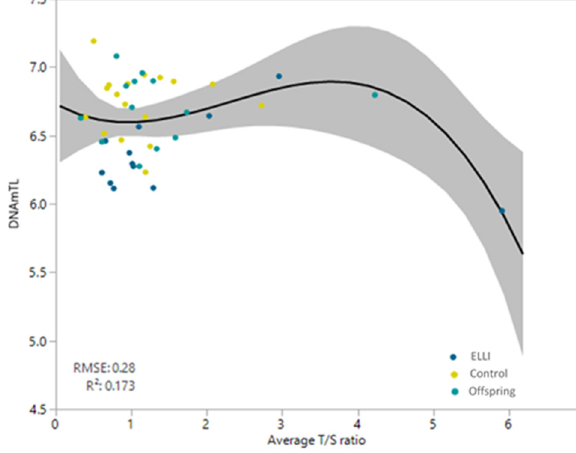
Figure A1. T/S ratio vs. DNAmTL. DNAmTL as a function of T/S ratio (telomeric concentration Figure A1. T / S ratio vs. DNAmTL. DNAmTL as a function of T / S ratio (telomeric concentration divided divided by SCG concentration). by SCG